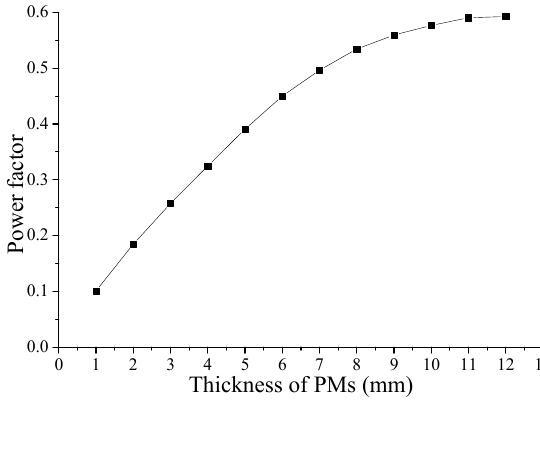
Figure 20. Variation of power factor versus thickness of PMs.